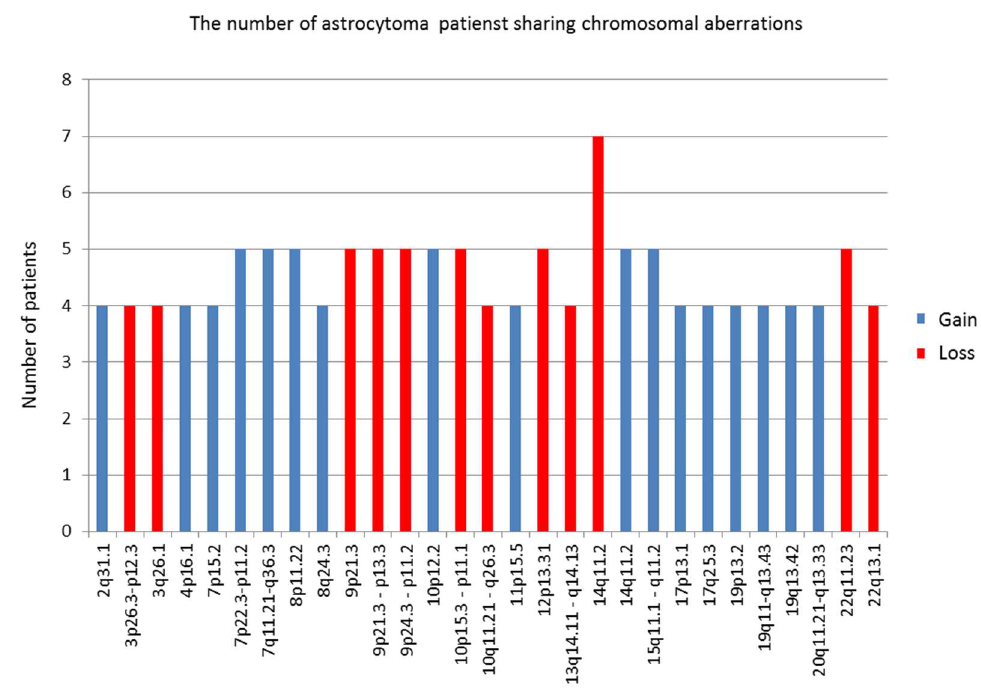
Figure 1. Frequent aberrant regions shared among the highest number of investigated patients.